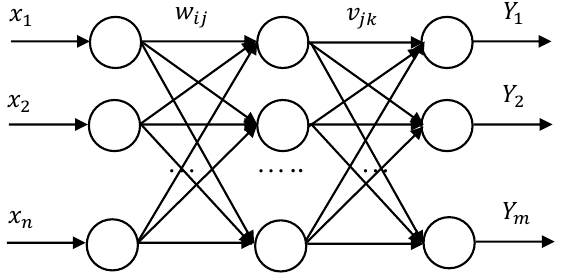
Figure 1. Three - layer back propagation (BP) neural network structure [24]. Figure 1. Three-layer back propagation (BP) neural network structure